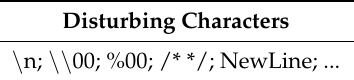
Table 5. Remove Disturbing